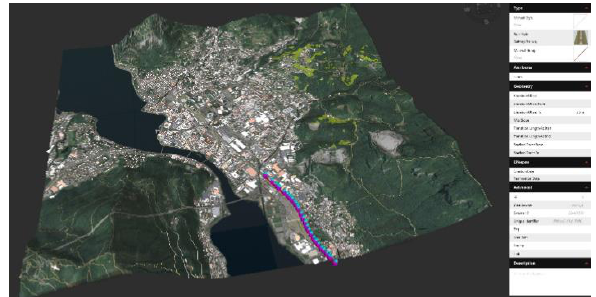
Figure 3. Integrated BIM/GIS model for the city of